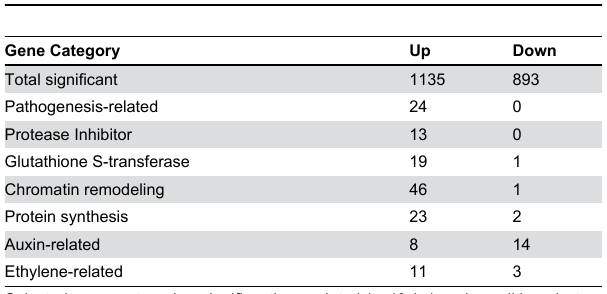
Table 2. Gene categories differentially regulated in ECB- damaged stem tissue.